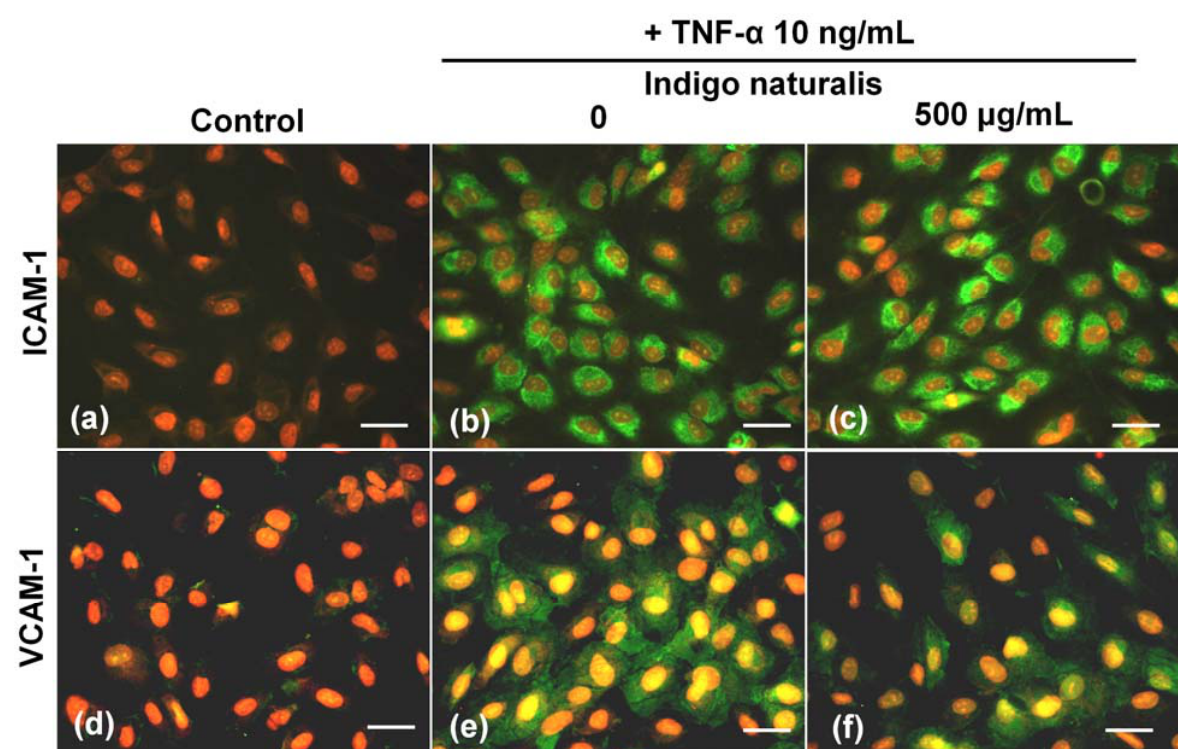
Figure 2. Effect of indigo naturalis extract on TNF- α induced expression of adhesion molecules.